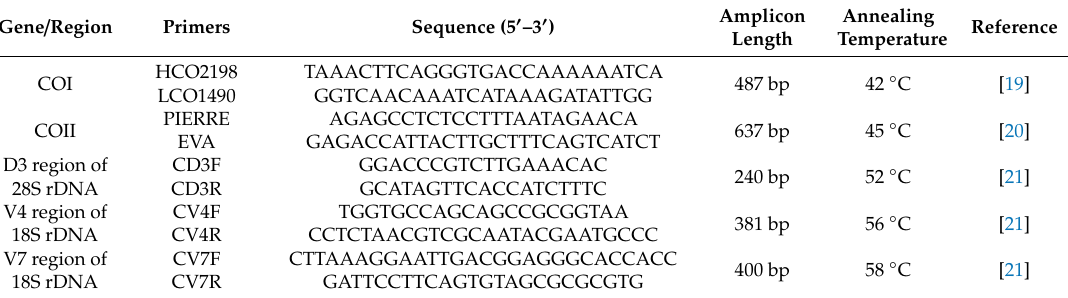
Table 1. Primer sequences and amplicon lengths of PCR products of target